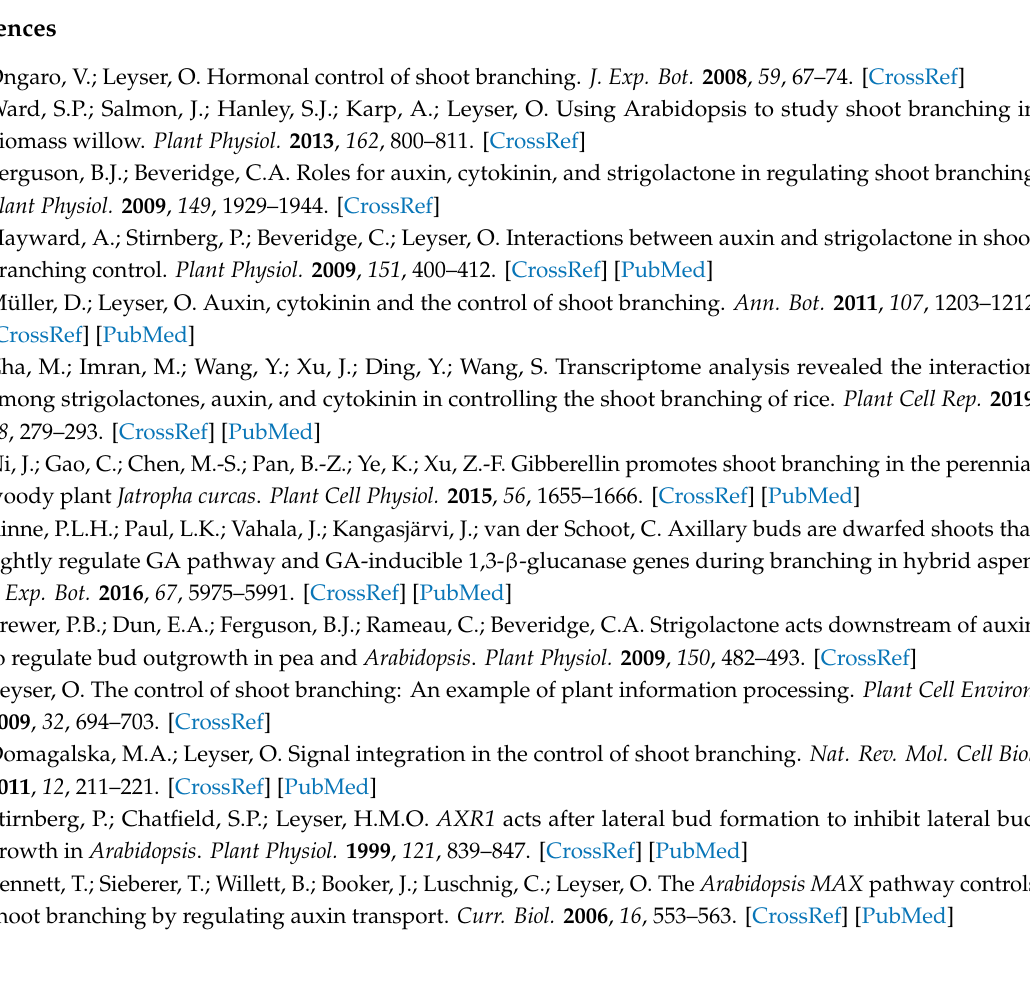
Table S1: Statistics of the 102 DEGs associated with auxin, CKs, SLs, and GAs for shoot branching in willow, Table S2: Details of the gene regulation network of hormone-related genes in